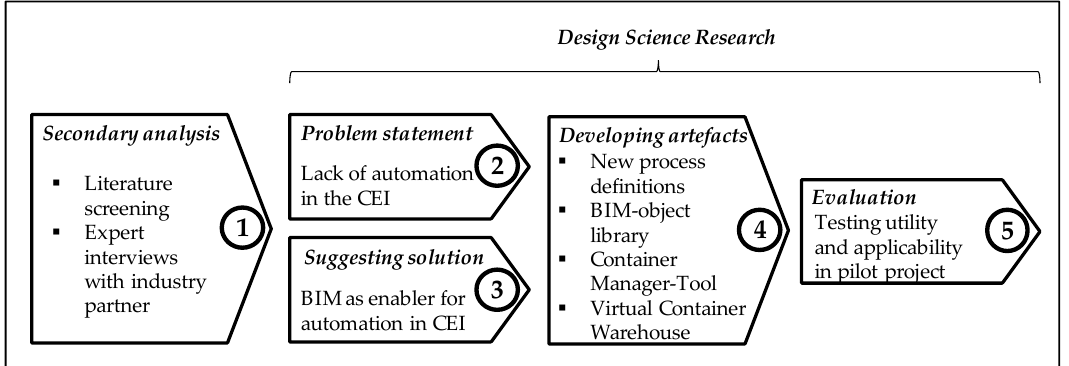
Figure 2. Research Figure 2. Research strategy.